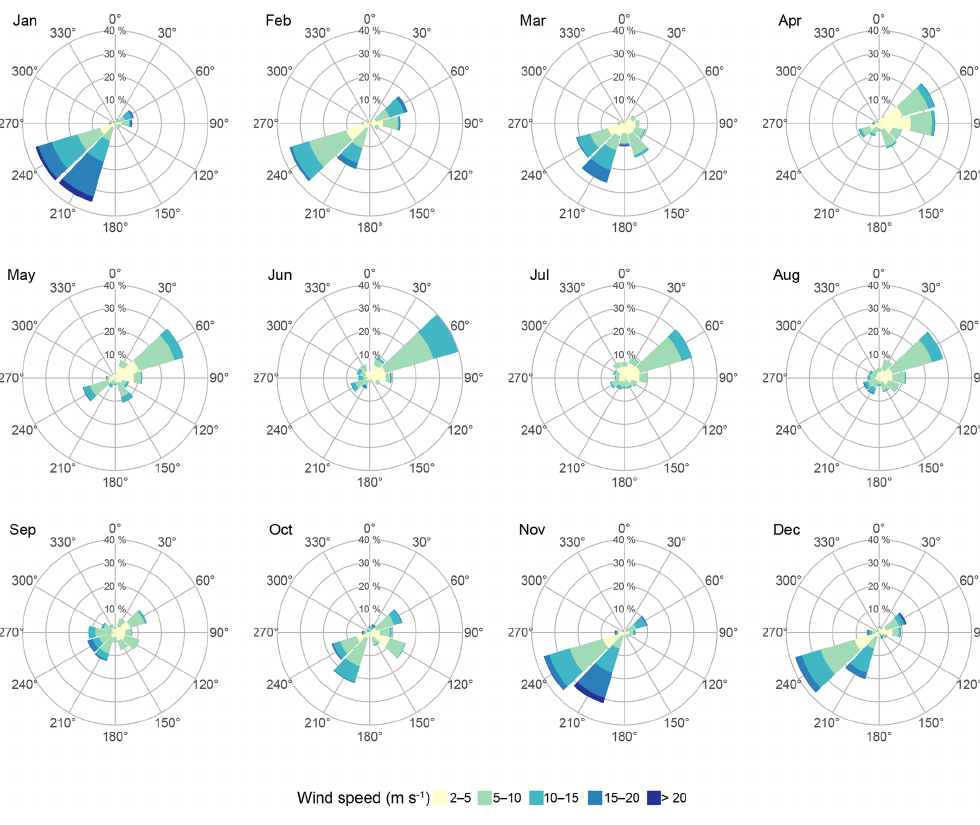
Figure 6. Wind distribution at Ambarchik for wind speeds>2ms − 1 for the period from August 2014 to April 2017.